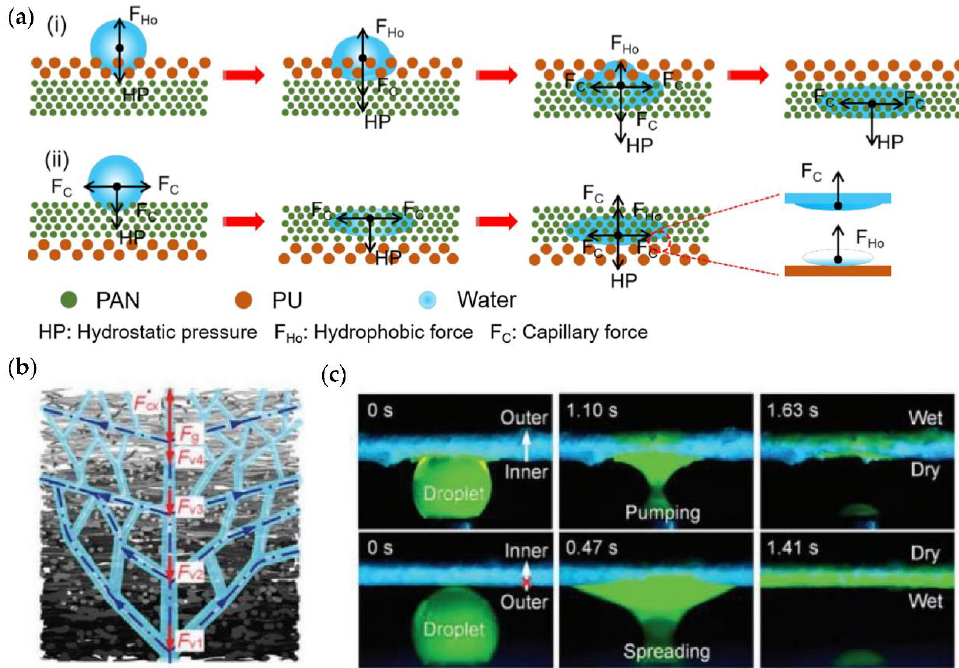
Figure 2. ( a ) The possible mechanism for directional water transfer by a hydrophobic/superhydrophilic Janus membrane [29] (Copyright 2020, Elsevier Inc.). ( b ) Illustration of the spontaneous vertical wicking in the multilayer membrane. ( c ) Fluorescence images of the antigravity water transport in the multilayers [30] (Copyright 2021, Wiley-VCH).